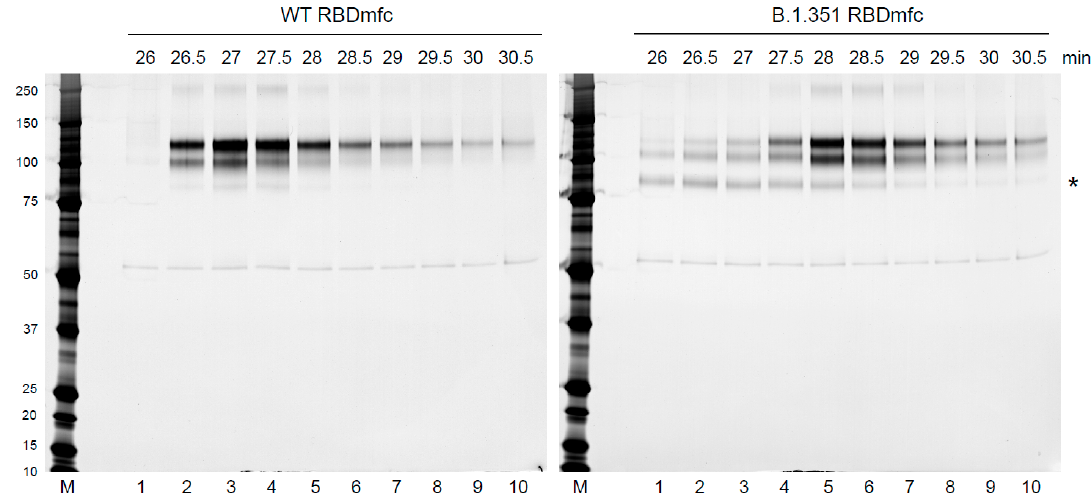
Figure A5. Uncroppedsilver-stainedgel shownin Figure 6.